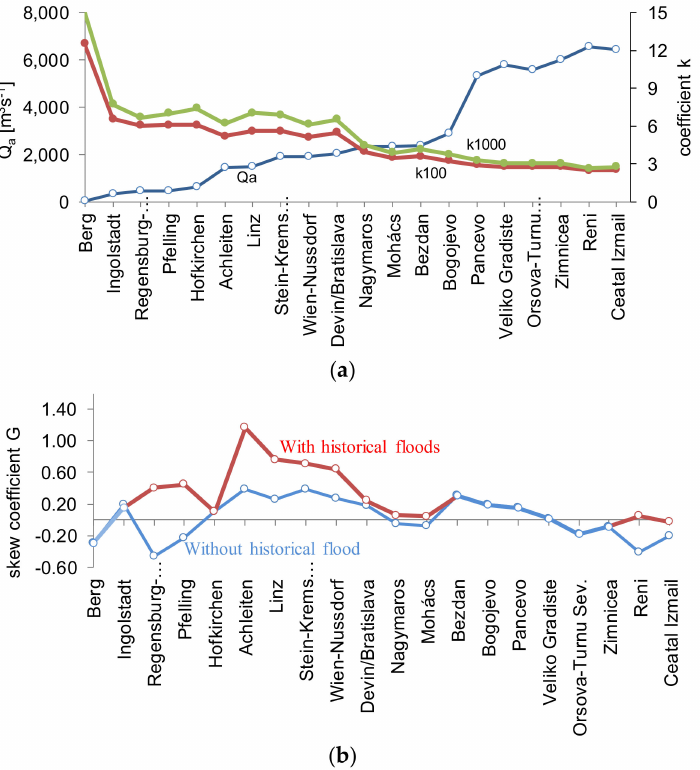
Figure 6. The course of the ( a ) ratio k of Q T /Q a at gauge stations along the Danube River, and ( b ) station skew coefficient G with and without historical floods along the Danube River.